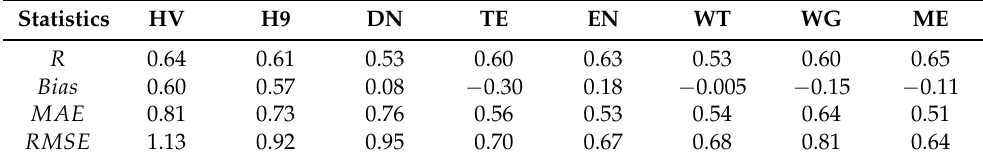
Table 2. ECACN 16 C 2 n profiles